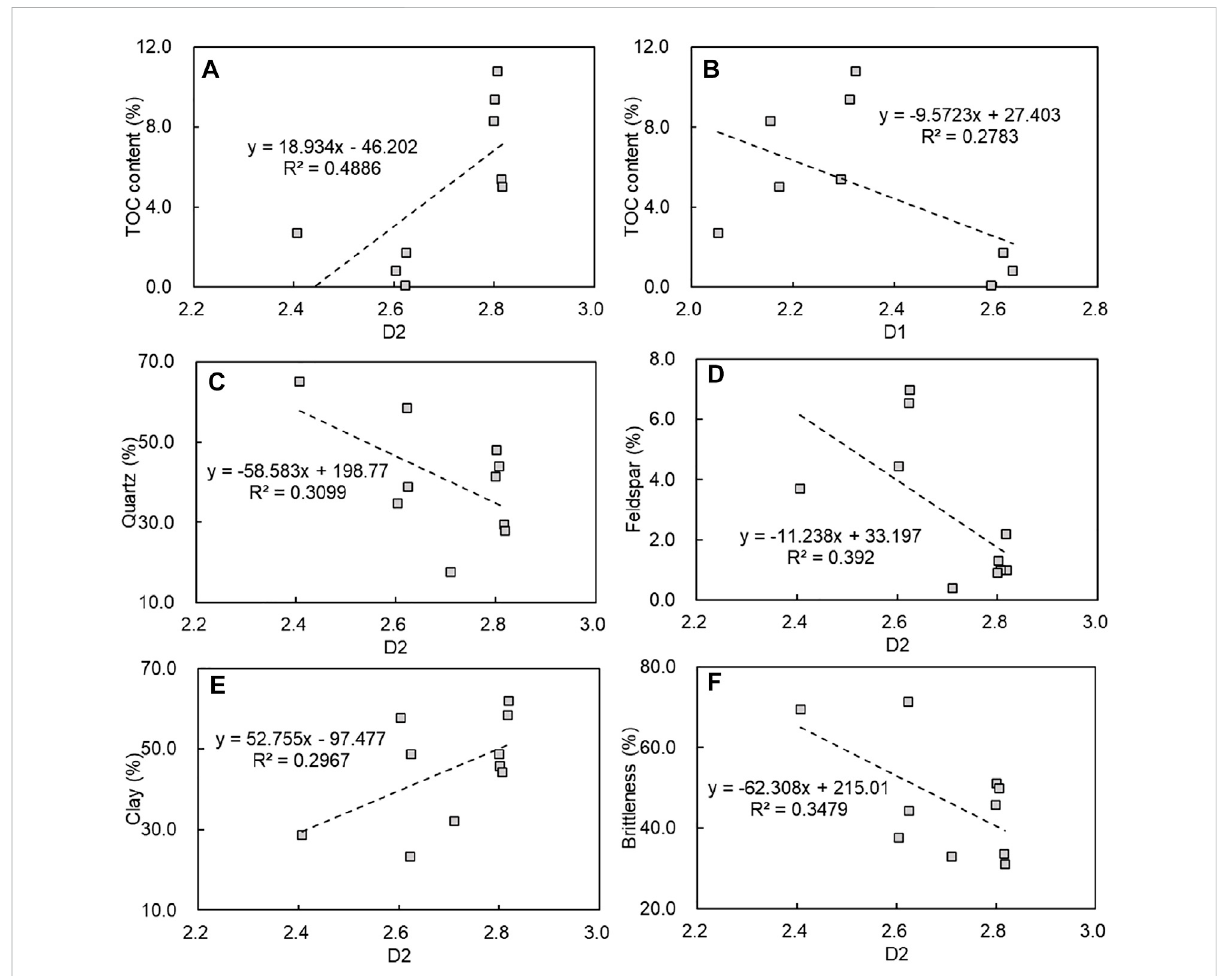
FIGURE 11 Relationship between shale composition, brittleness and fractal